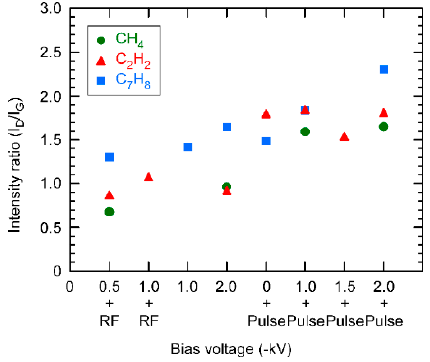
Figure 4. Intensity ratio I D /I G of the single DLC layers prepared with different conditions as indicated.